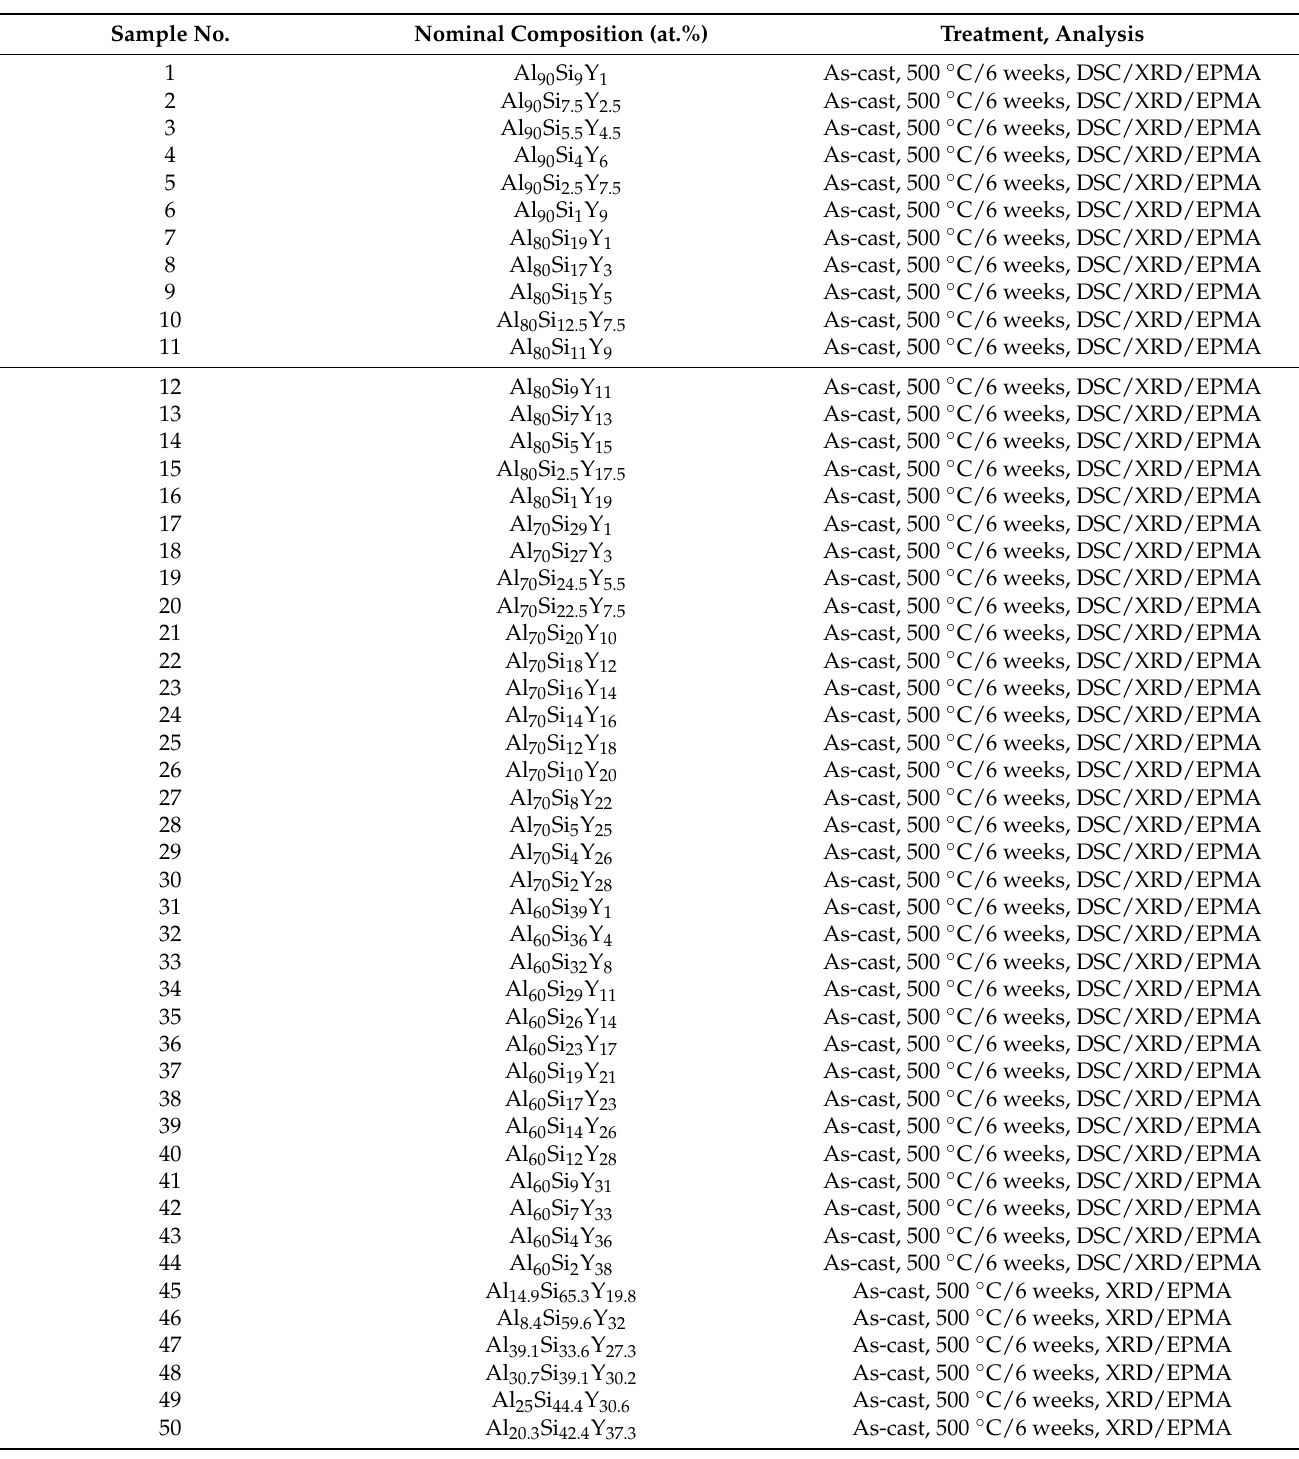
Table 1. Alloy compositions, heat treatment schedule and the analysis methods in the Al–Si–Y system. Sample